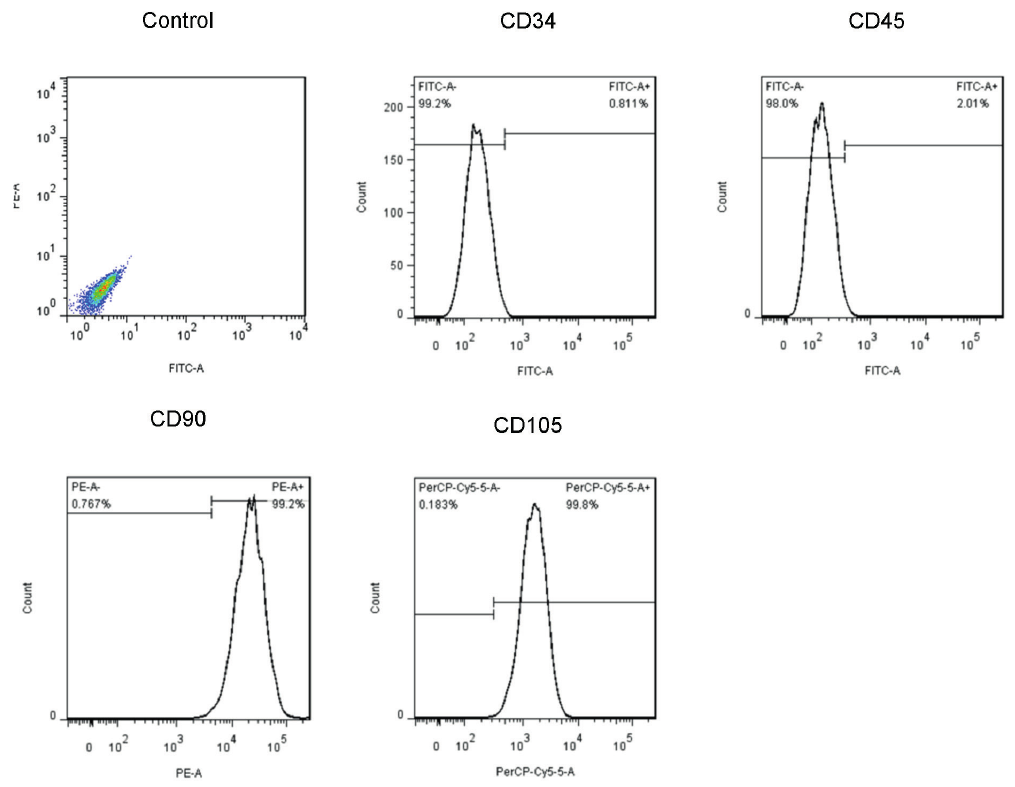
Figure 1 - Detection of cell surface antigen of canine BMSCs by Flow cytometry. (n = 3). Canine BMSCs highly expressed CD105 (99.8%) and CD90 (99.2%), and lowly expressed CD45 (2.01%) and CD34